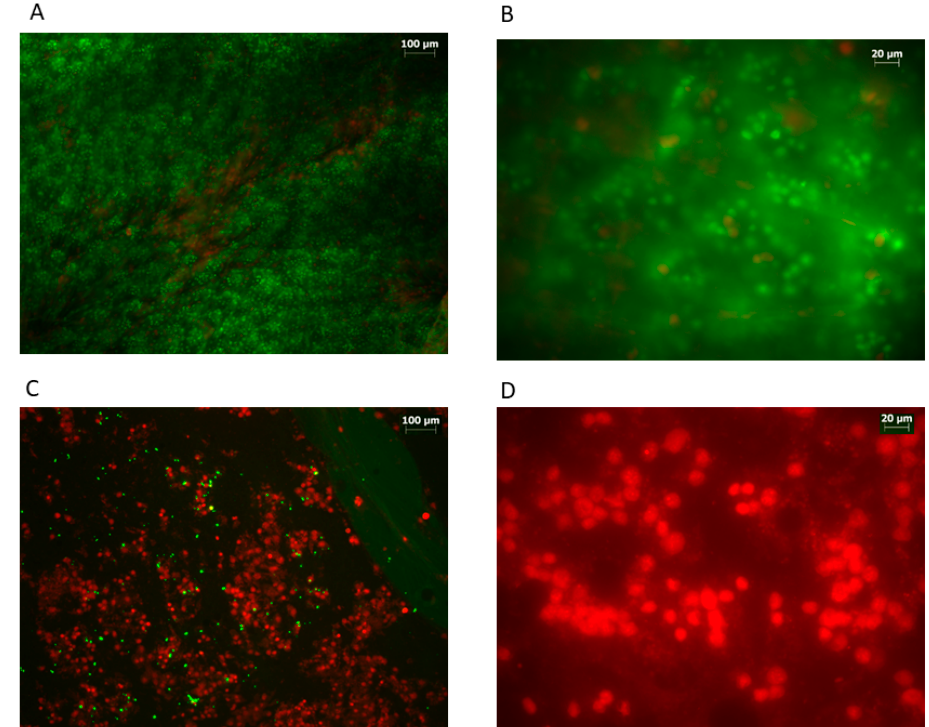
Figure 1. Example images of intestines isolated from healthy ( A , B )—magnification 100×, and N. ceranae -infected honeybees ( C , D )—magnification 400×. The intestines were stained with live/dead (Syto 9/PI) stains and observed under an Axiovert 200M fluorescence microscope, Zeiss.